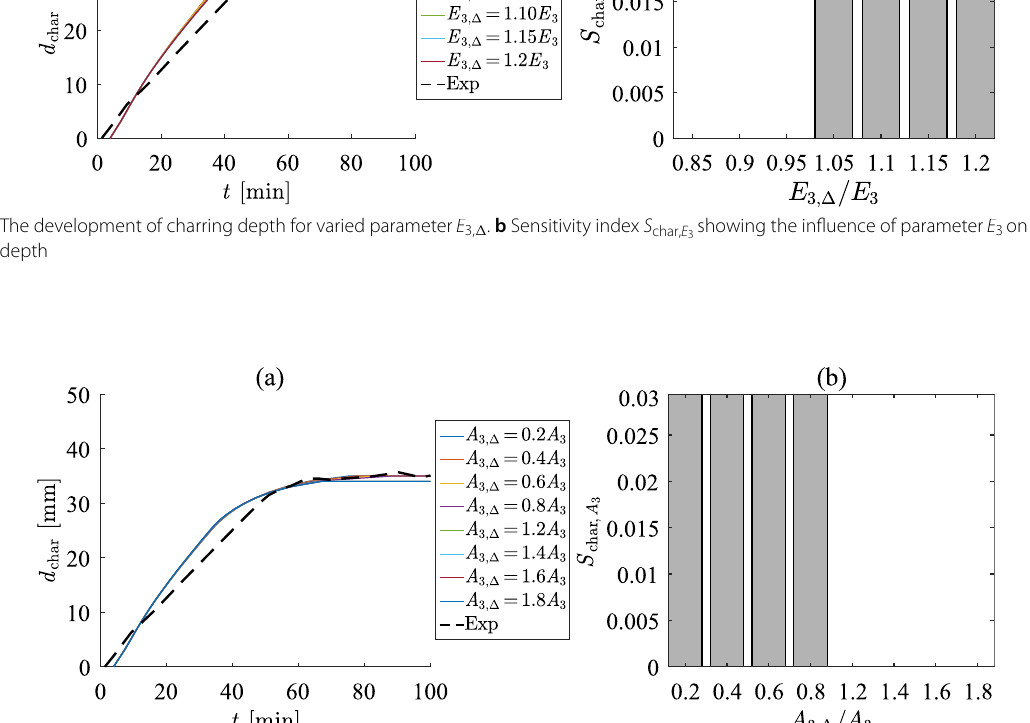
showing the influence of parameter A 3 on the 3